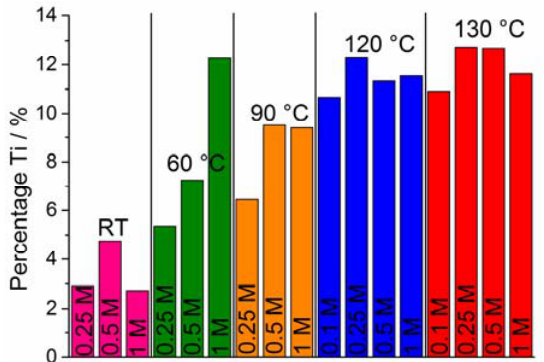
Figure 3. Titanium content in percentage on the PES membranes with TiO 2 nanoparticles synthesized at different temperatures (RT, 60 °C, 90 °C, and 130 °C) and with different amounts of HCl (0.25 M, 0.5 M, and 1 M) measured with XPS.